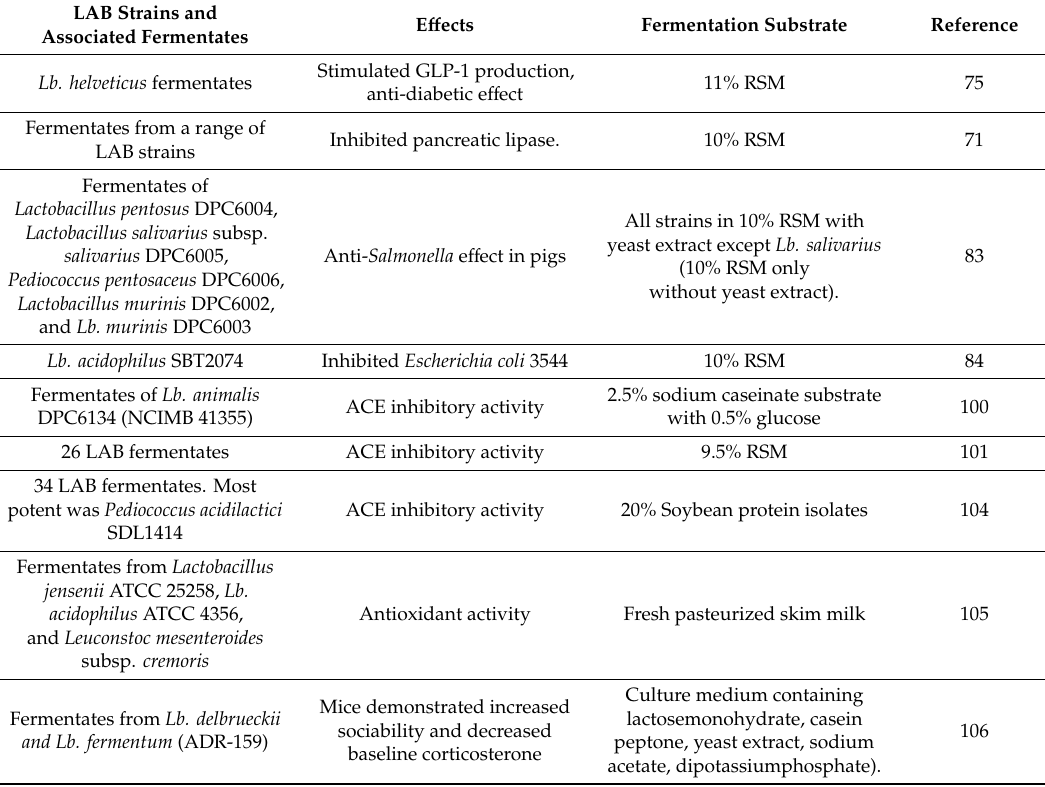
Table 2. Publications relating to health benefits of LAB